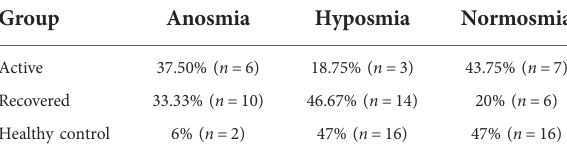
TABLE 4 COVID diagnosis groups ’ degree of smell loss in UPSIT